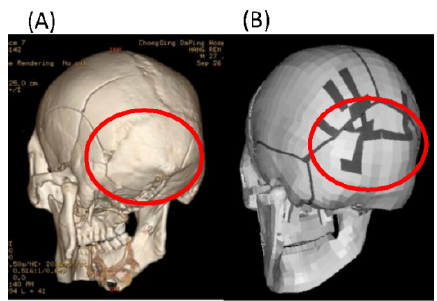
Figure 5. Comparison of skull fracture patterns between the ( A ) experiment and ( B ) simulation.